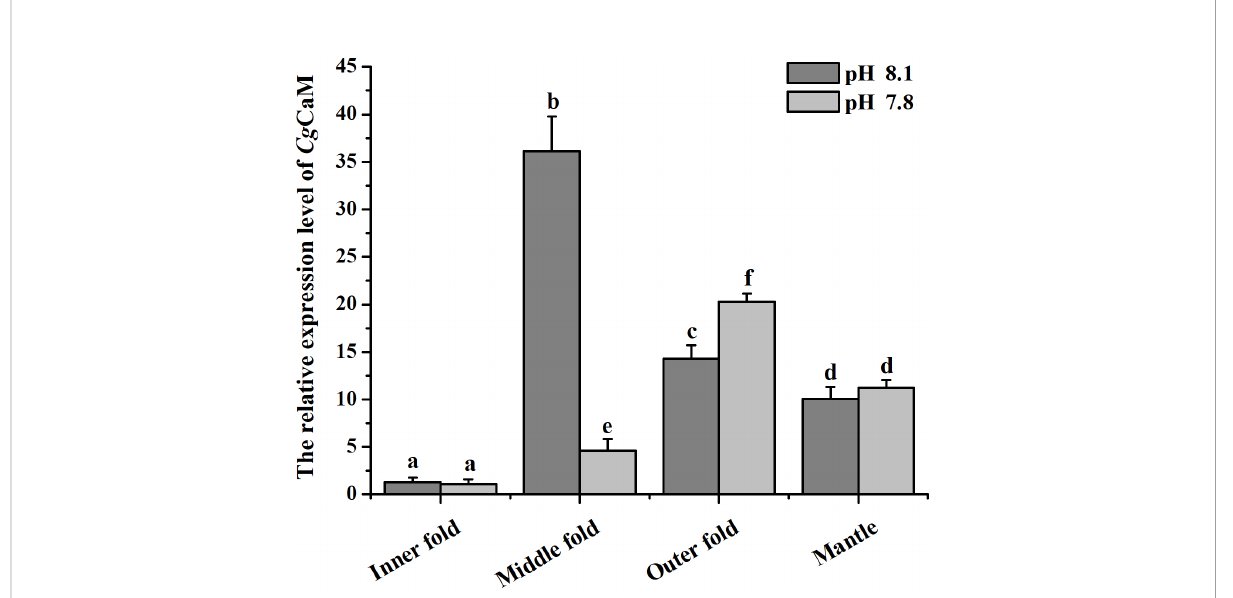
FIGURE 3 The mRNA expression level of Cg CaM in different folds of mantle under acidi fi cation treatment. Each value was shown as mean ± S.D. ( N = 3), and the signi fi cant differences ( p < 0.05) were marked by different letters